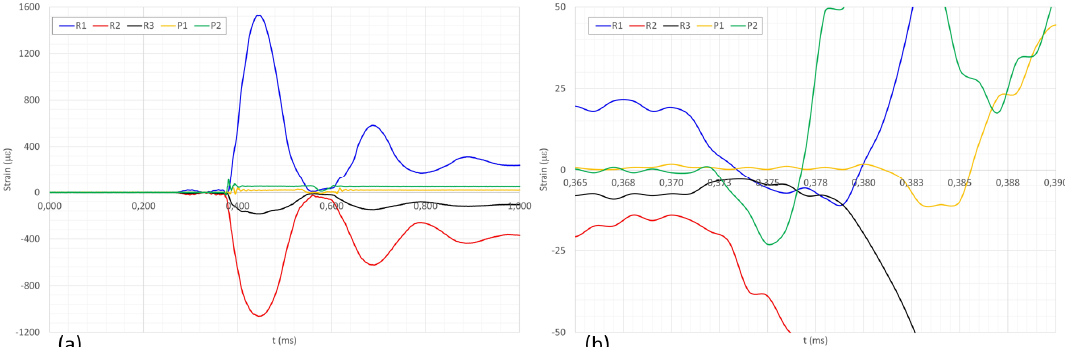
Figure 8. Drop-test performed from a height of 5 cm: FBGs Strain measurements vs. time. ( a ) The complete test from the initial resting phase to the rebounds that occur after the impact between the wheels and the ground; ( b ) Magnification of the interval during which impact occurs.